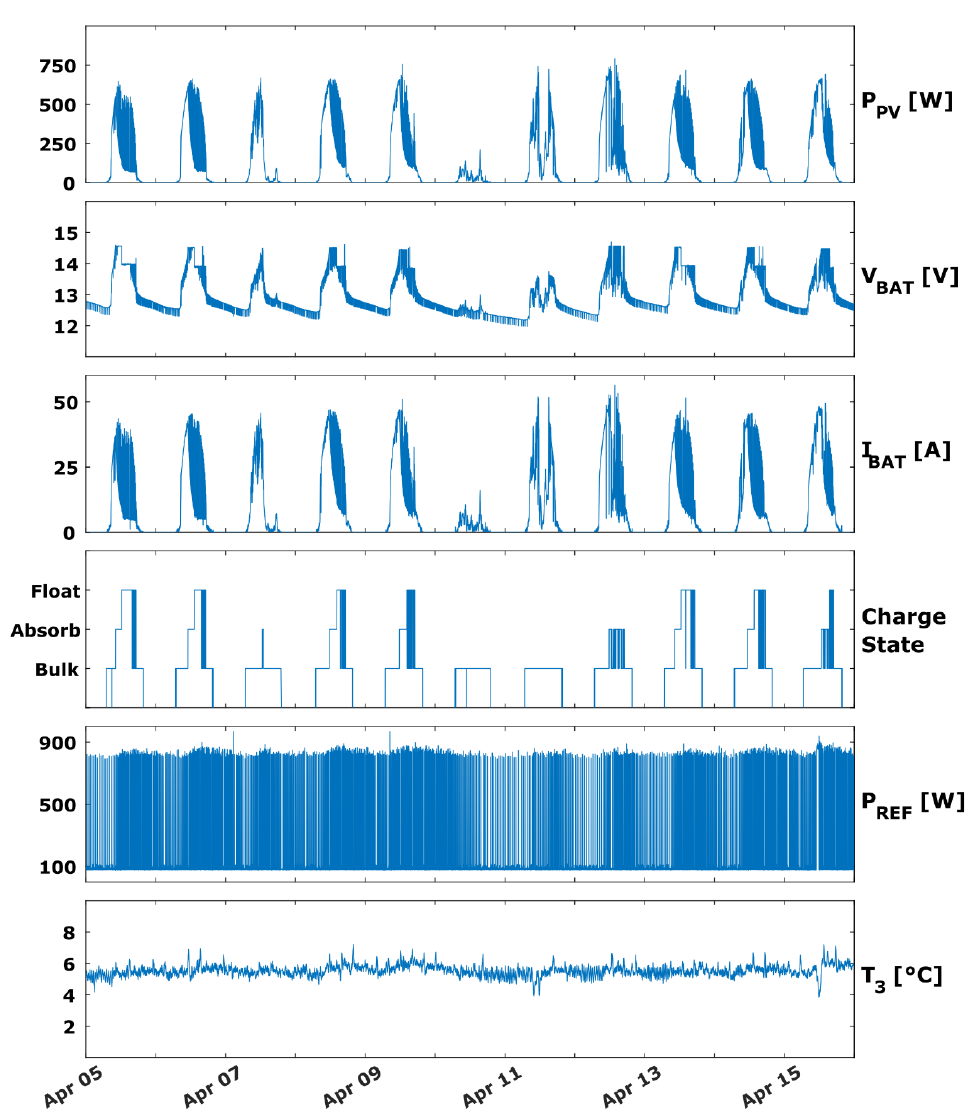
Figure 12. Data recorded by the vending machine between 5 and 15 April 2022 .